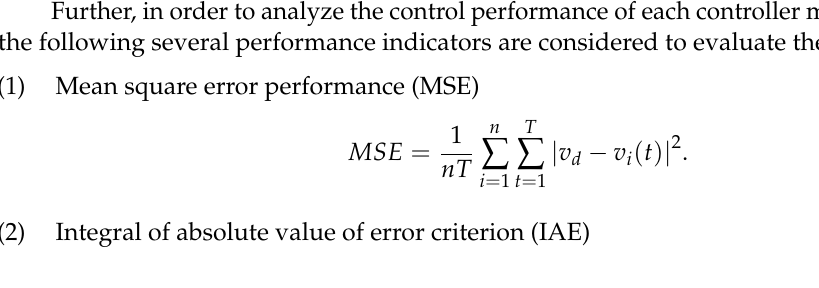
Integral of absolute value of error criterion